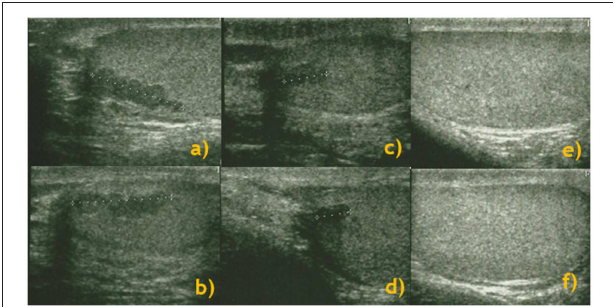
FIGURE 1 | Longitudinal study: testis ultrasound performed at baseline [right (a) and left (b) testes], and 3 months [right (c) and left (d) testes] and 6 months [right (e) and left (f) testes] after cortisone therapy and a consequent improvement in ACTH levels.